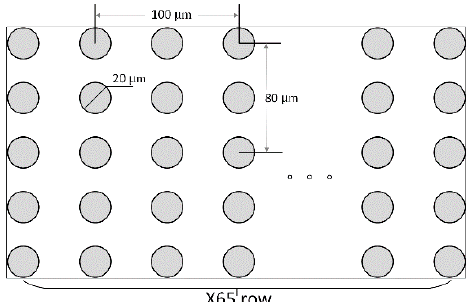
20 of 21 Table A2. Area evaluations on three stacked layers. Layer